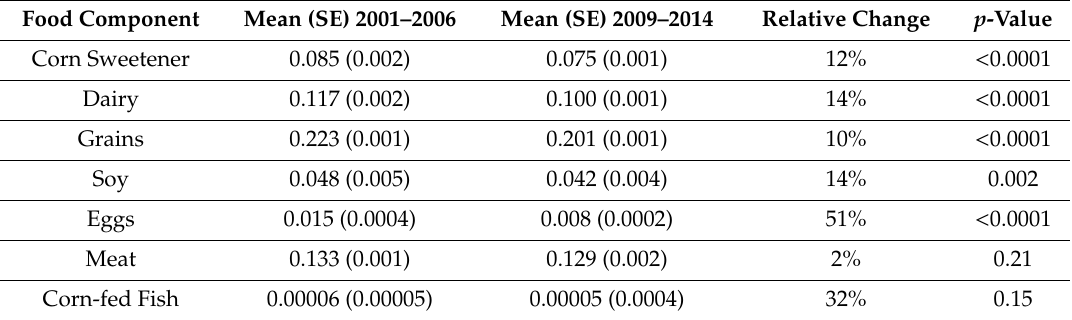
Table 4. Changes in food components making up the subsidy